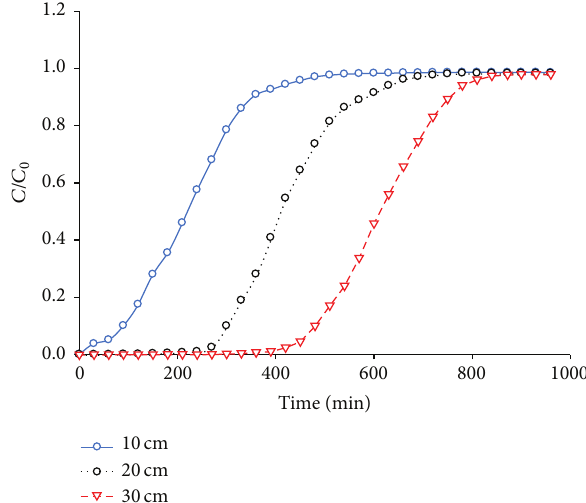
Figure 16: Breakthrough curves at different bed depths for adsorp- tion of copper ions onto